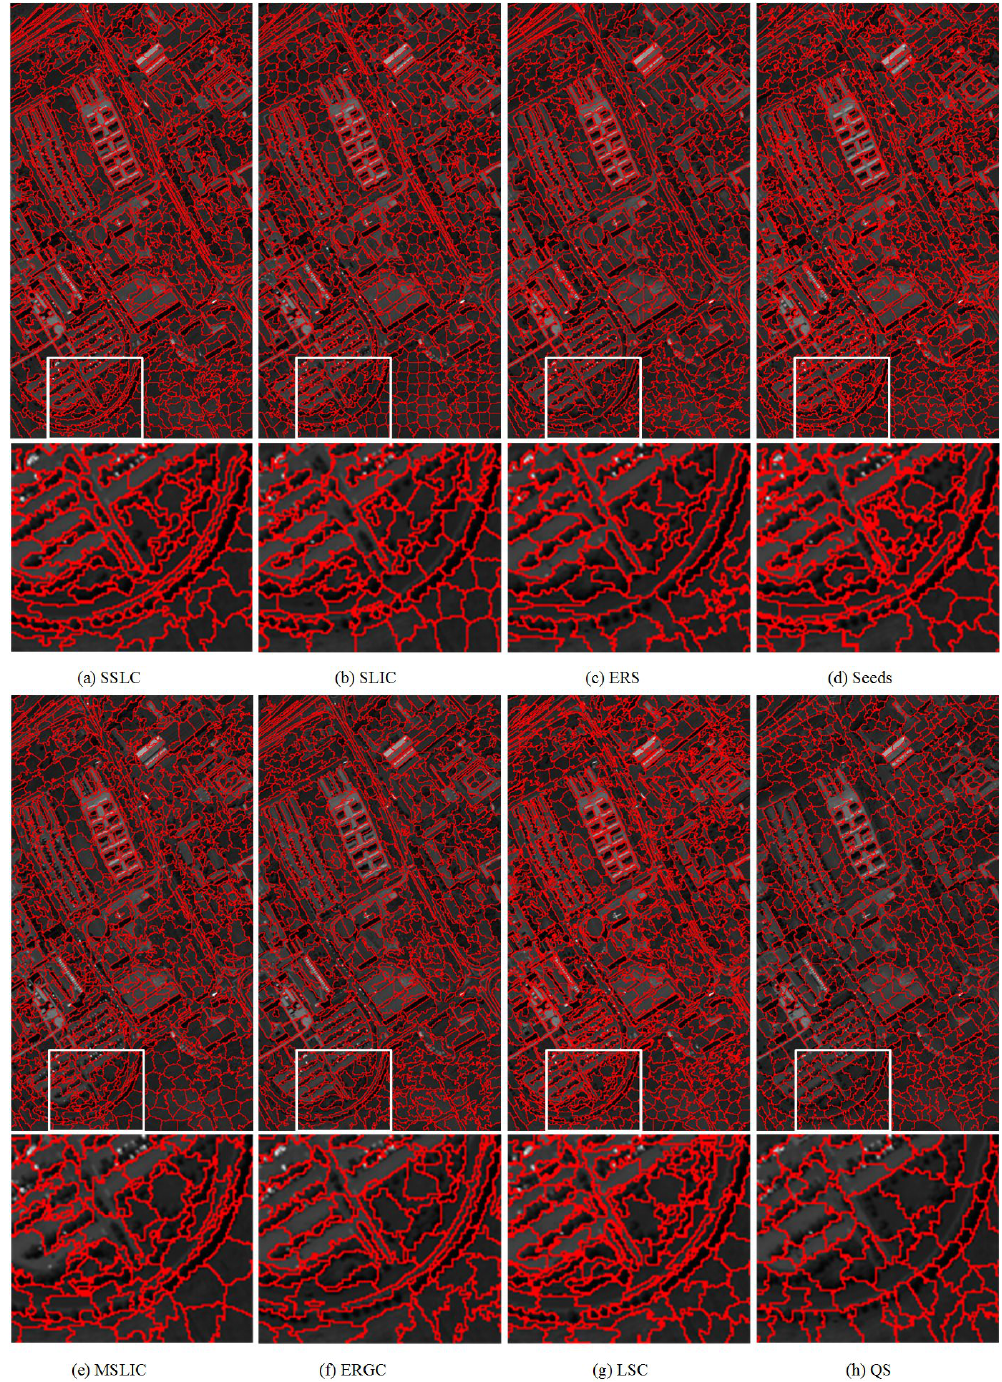
Figure 13. The first and third rows are superpixel segmentations of the Reflective Optics System Imaging Spectrometer (ROSIS) image PaviaU provided by: ( a ) Superpixel Segmentation with Local Competition (SSLC); ( b ) SLIC; ( c ) Entropy Rate Superpixel (ERS); ( d ) Seeds; ( e ) MSLC; ( f ) ERGC; ( g ) Linear Spectral Clustering (LSC); and ( h ) Quick Shift (QS). The second and fourth rows zoom in on the regions of interest as defined by the white boxes to facilitate close visual